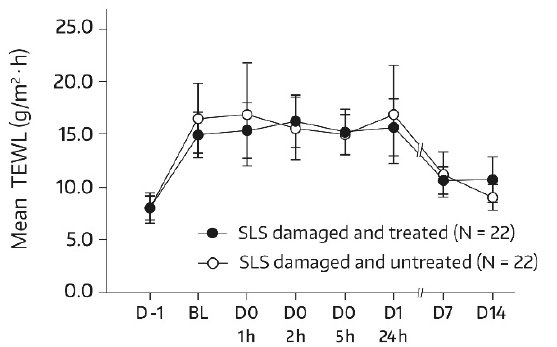
Figure 3. Results from the TEWL measurements (forearm) in untreated SLS-damaged skin and